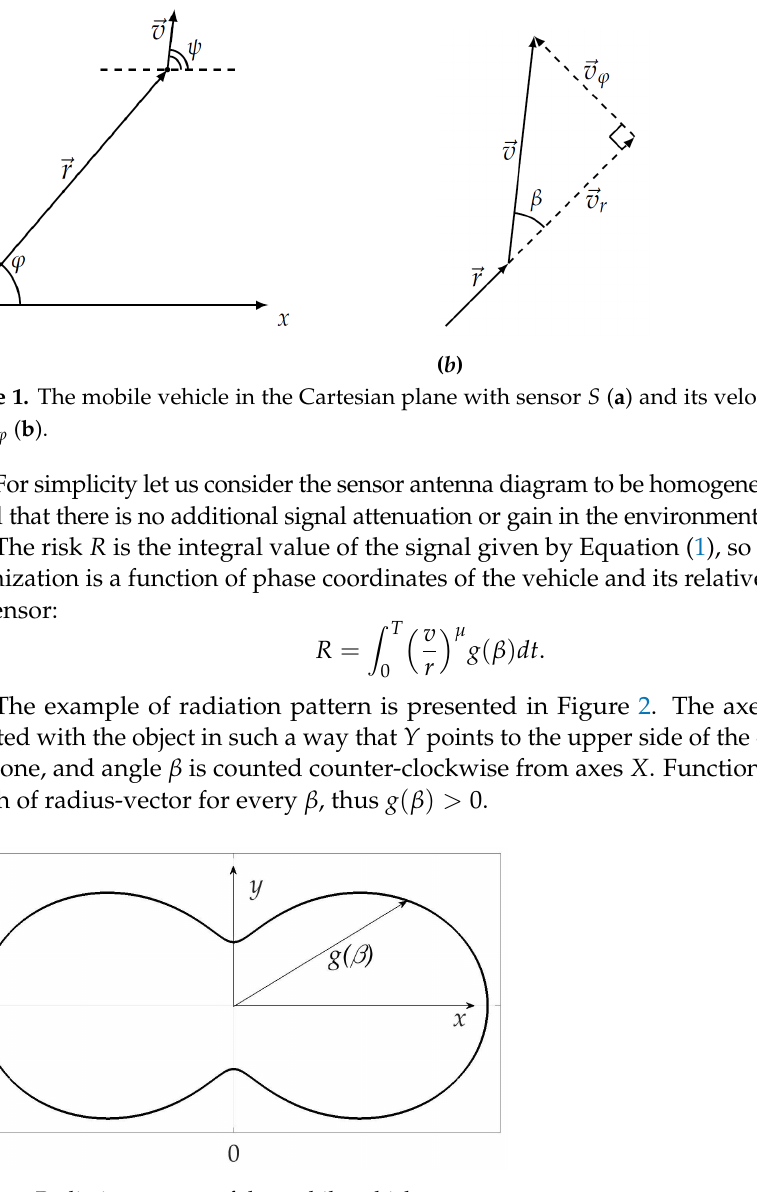
Figure 2. Radiation pattern of the mobile